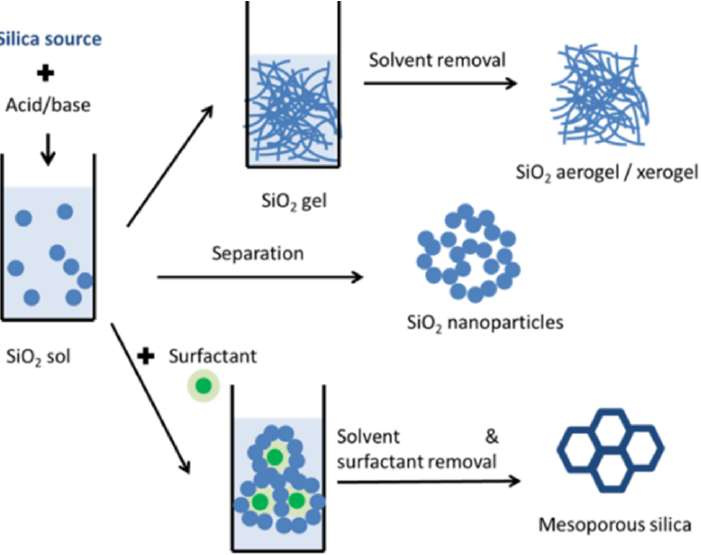
Figure 2. Schematic representation of porous silica solution synthesis methods. Porous glass is commonly obtained using an acid soluble glass phase as a hard template. This soluble phase is removed by mineral acid treatment, leaving behind a disordered, porous structure [45]. Polymer nanoparticles can be used as a hard template, leading to the creation of silica hollow spheres